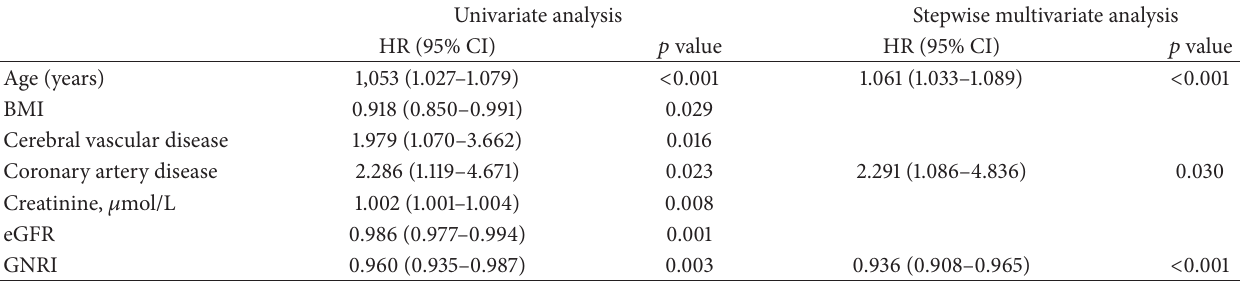
Table 3: Independent predictor of all-cause mortality in DFU with minor